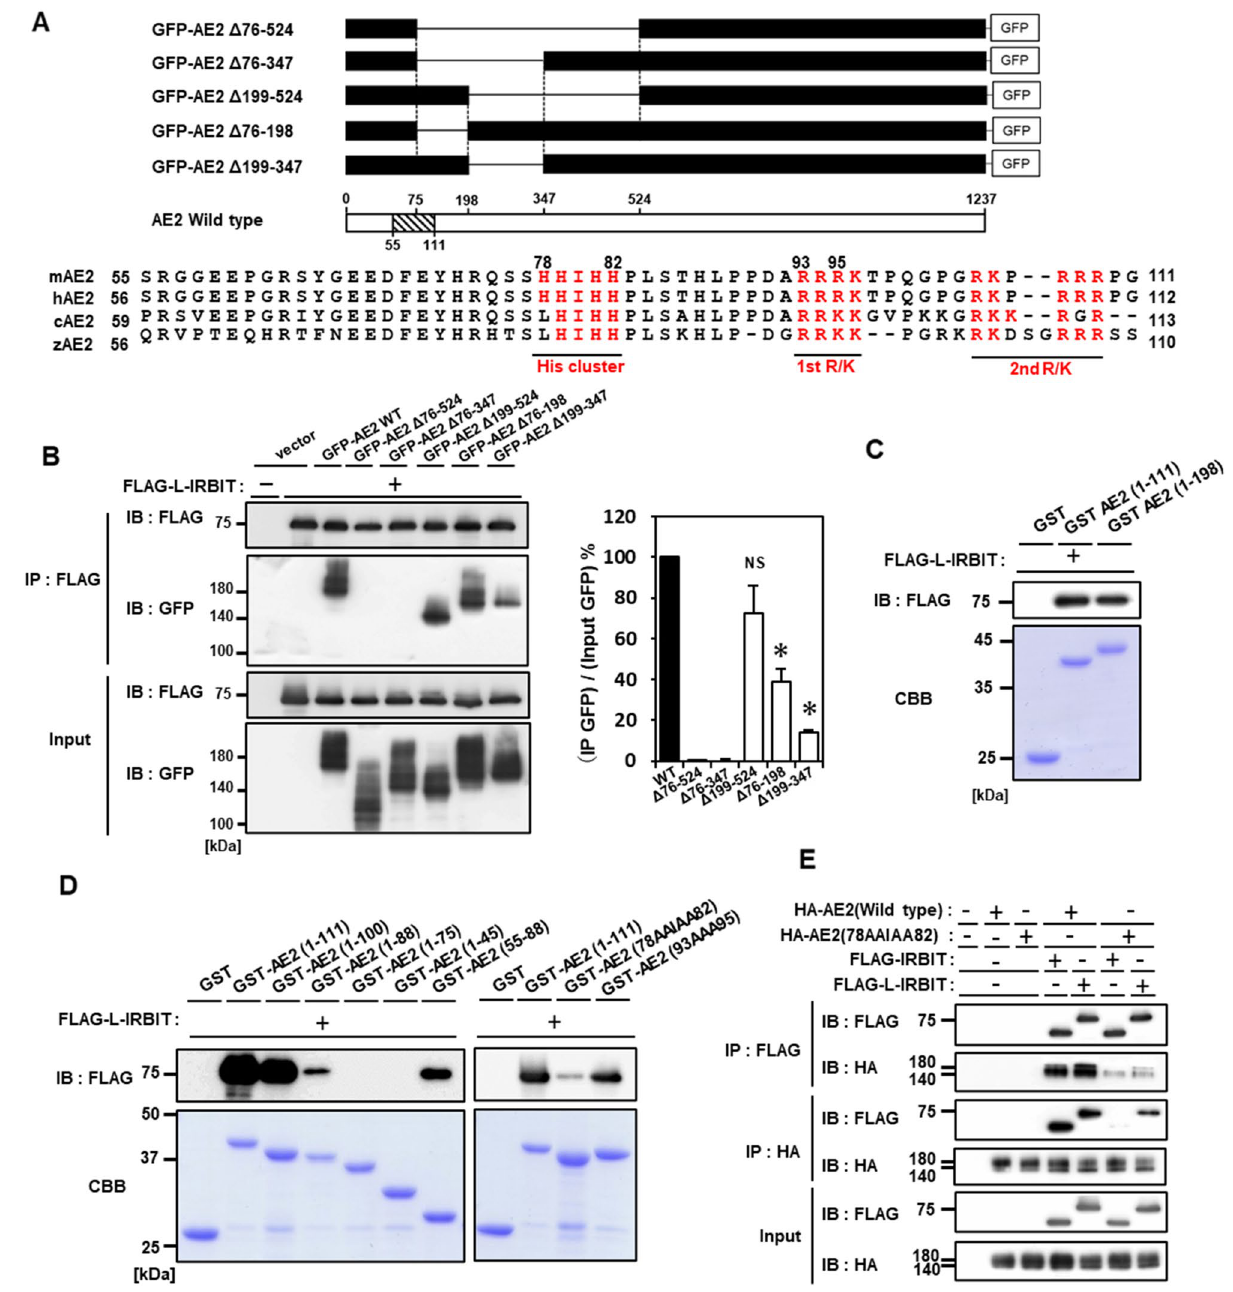
Figure 4. His cluster in the N-terminal region of AE2 is involved in the interaction between AE2 and IRBIT family proteins. ( A ) Schematic diagram of GFP-tagged AE2 deletion mutants (upper panel). Sequence alignment of the N-terminal regions (aa 55–111, in mouse) of various species AE2. Red letters indicate clusters of basic amino acids and are designated as His cluster, 1st R/K cluster, and 2nd R/K cluster, respectively. mAE2: mouse AE2, NM_009207.3; hAE2: humanAE2, NM_003040.4; cAE2: chickenAE2, NM_204963.1; zAE2: zebrafish AE2, NM_001037237.1 (Lower panel). ( B ) FLAG-tagged L-IRBT was transfected into HEK 293 T cells alone or with GFP-tagged AE2. The lysate expressing each construct (input) was processed for immunoprecipitation with each indicated antibody (IP). Co-immunoprecipitation was analyzed using immunoblots with the indicated antibodies (IB) (left panel). Binding efficiency of each truncated AE2 mutant to L-IRBIT was calculated based on the GFP signals of co-immunoprecipitated/those of input. Relative binding efficiency of each truncated AE2 mutant is represented by the percentage of that of wild type AE2 (100%), N = 3. * P < 0.05, NS (no significance) (right panel). ( C , D ) FLAG- tagged L-IRBIT was transfected into HEK 293 T cells, and the lysate was pulled down by each GST-tagged fusion protein carrying the indicated N-terminal region with or without AE2 mutations. Bound L-IRBIT was examined using immunoblotting and anti-FLAG antibody. ( E ) HA-tagged AE2 wild type or mutant (aa 78–82) was transfected into HEK 293 T cells alone or with FLAG-tagged IRBIT family. The lysate expressing each construct (input) was processed for immunoprecipitation with each indicated antibody (IP). Co-immunoprecipitation was analyzed using immunoblots with the indicated antibodies